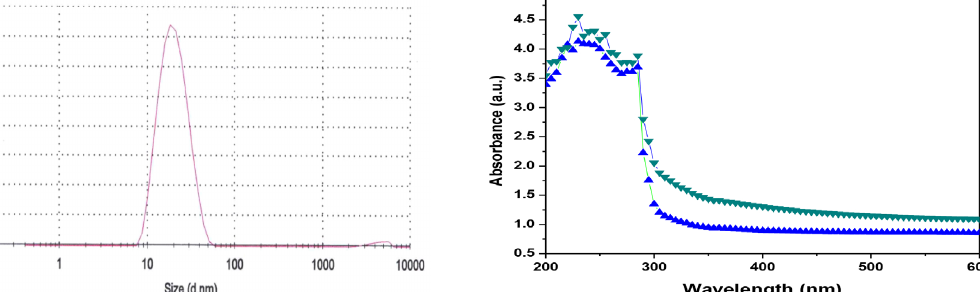
Fig. 5. Hydrodynamic size of B sample (nano-composite con- taining high Cu content) in cell culture medium